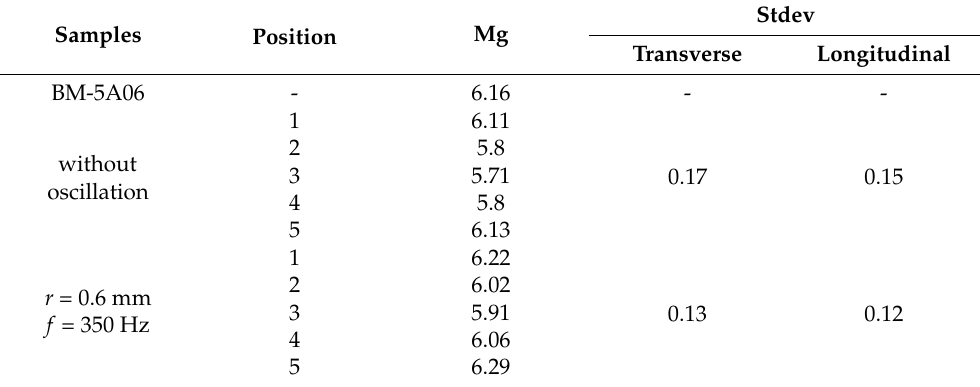
Figure 5. EBSD results of #1 and #8 welded joints, ( a ) IPF cross sections of CGZ in #1 weld; ( b ) IPF cross sections of CGZ in #8 weld; ( c ) statistical comparison of grain size distribution in CGZ of #1 and #8 welds; ( d ) IPF cross sections of EQZ in #1 weld; ( e ) IPF cross sections of EQZ in #8 weld; ( f ) statistical comparison of grain size distribution in EQZ of #1 and #8 welds. Table 3. The test results of XRF in the